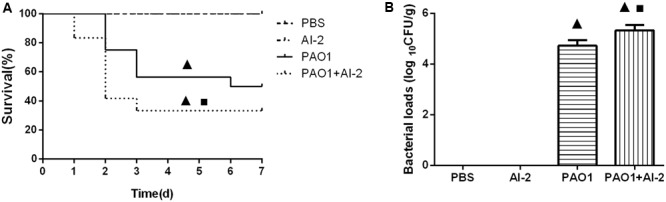
Analysis of survival data and bacterial loads after infection. The animals were treated with PBS, AI-2, P. aeruginosa PAO1 (P) and AI-2+P. aeruginosa PAO1 (P+AI-2), respectively. Triangles denote a statistically significant difference from the PAO1 group (P < 0.05), asterisks denote a statistically significant difference from the PBS group (P < 0.05). (A) Survival was monitored for 7 days (n = 12 mice per group); (B) Bacterial loads in the lungs after infection for 24 h.